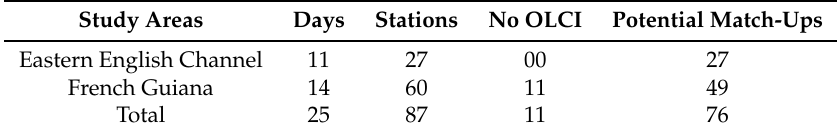
Table 1. The number of days, stations, and stations where OLCI data were not available and potential match-ups by study area. Study Areas Days Stations No OLCI Potential Match-Ups Eastern English